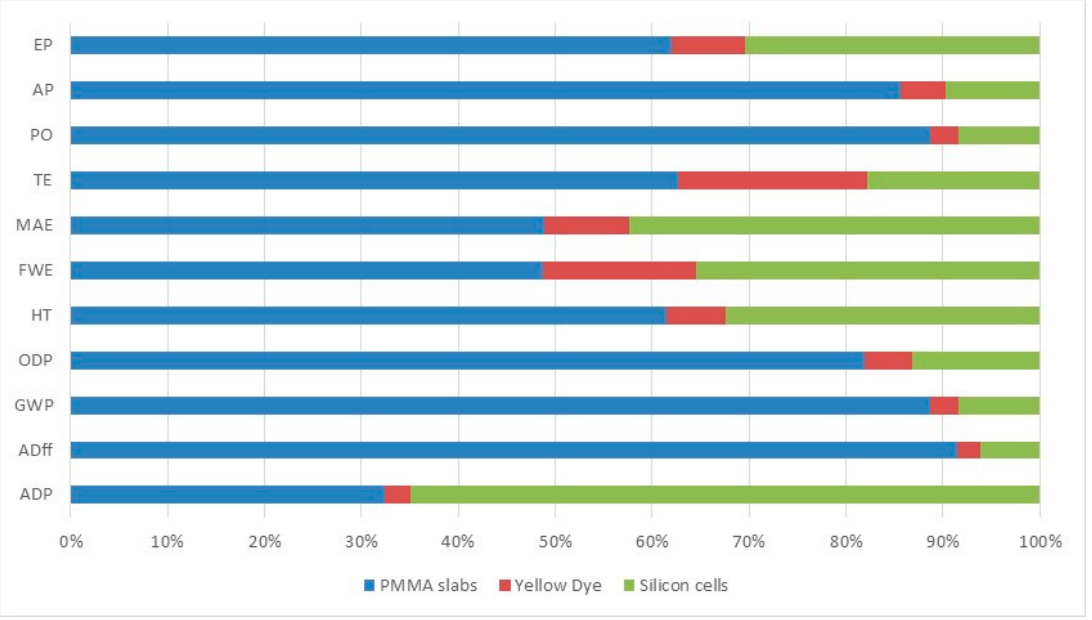
Figure 4. Environmental impacts of LSC module (1 m 2 ).